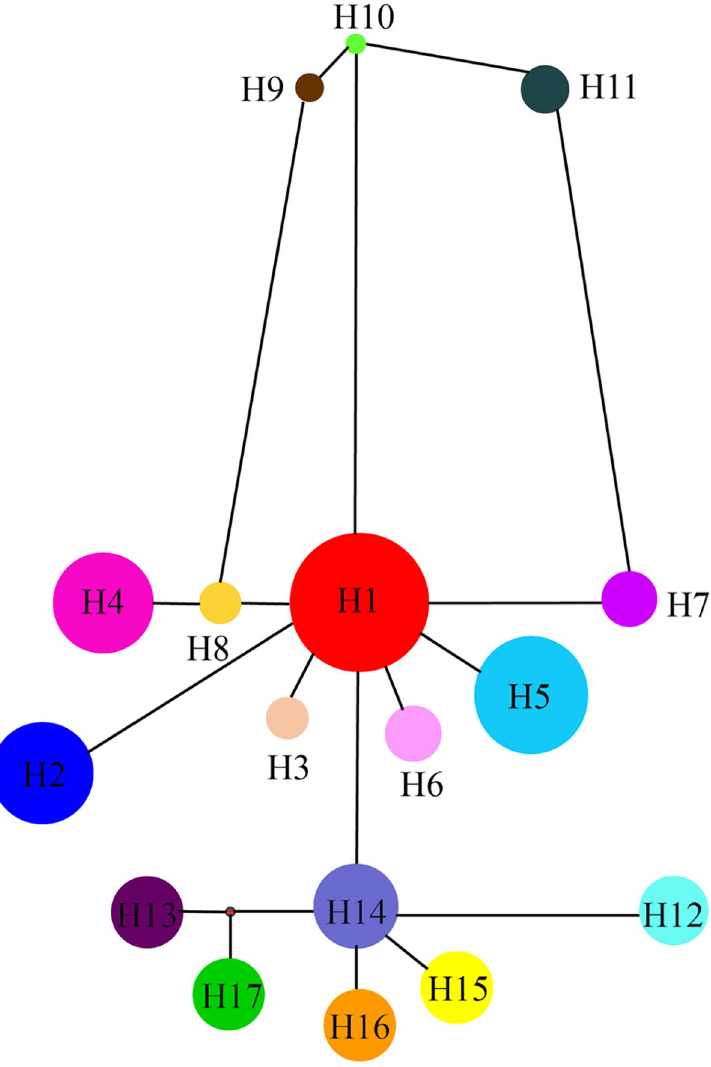
Fig 3. Statistical parsimony network of 17 haplotypes of Tugarinovia mongolica based on two cpDNA regions. The size of each circle is proportional to the frequency of the haplotype. The haplotypes H1-H11 are found exclusively in the northern group (NG), while haplotypes H12-H17 are found exclusively in the southern group (SG).